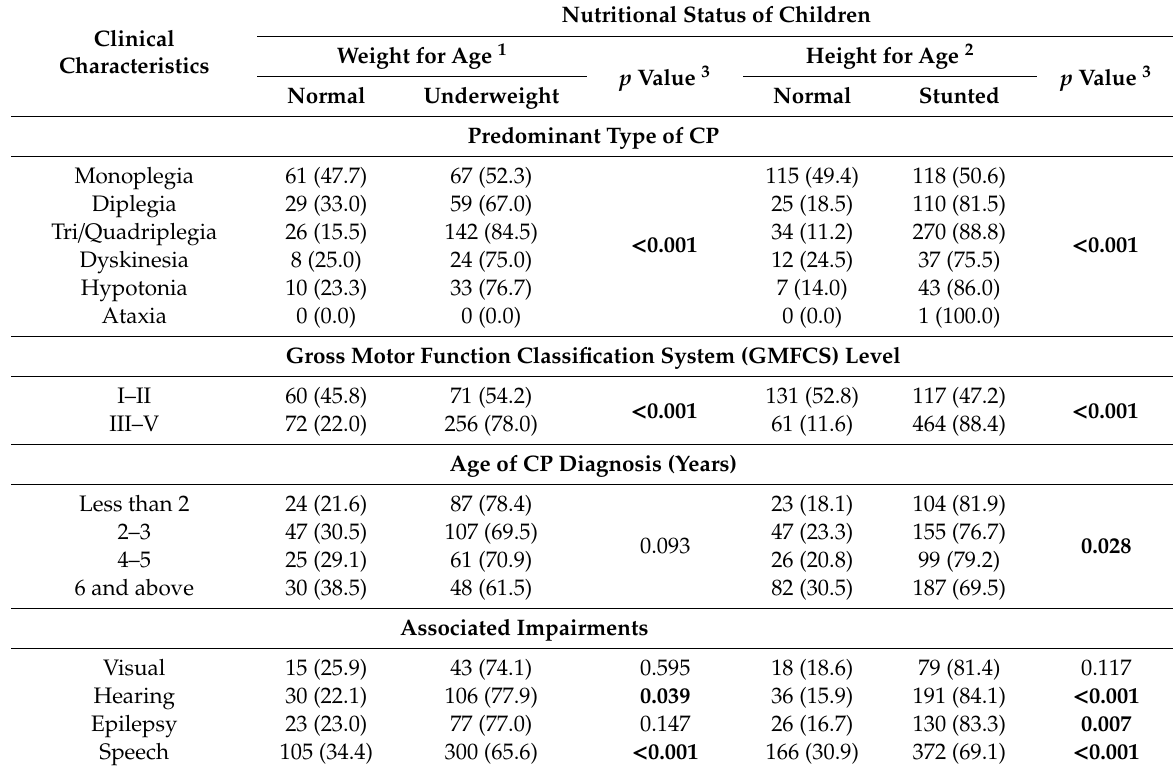
Table 5. Nutritional status of children with cerebral palsy (CP) ( n =